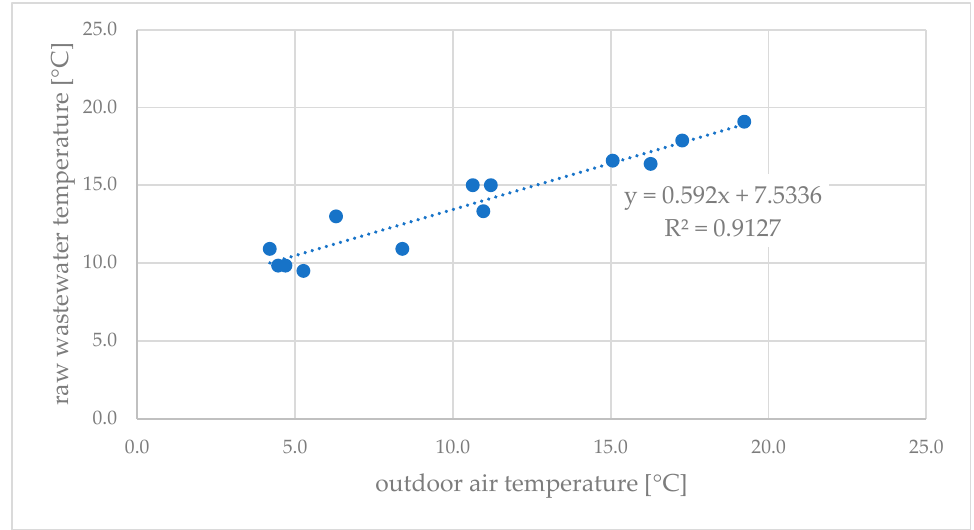
Figure 3. Correlation between wastewater temperature and air temperature.